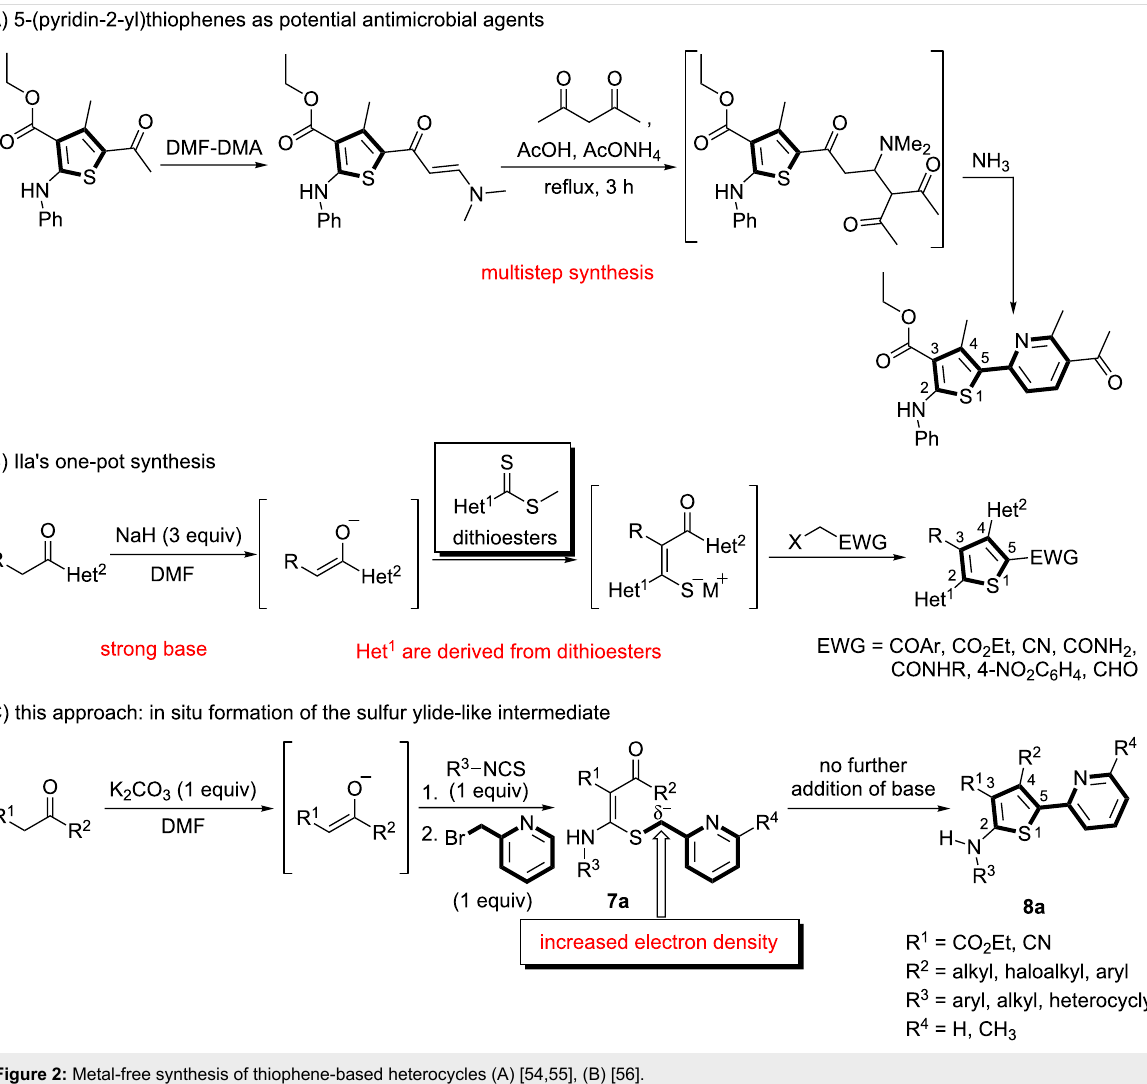
phene 8aa in an excellent yield (92%, Table 1, entry 1).